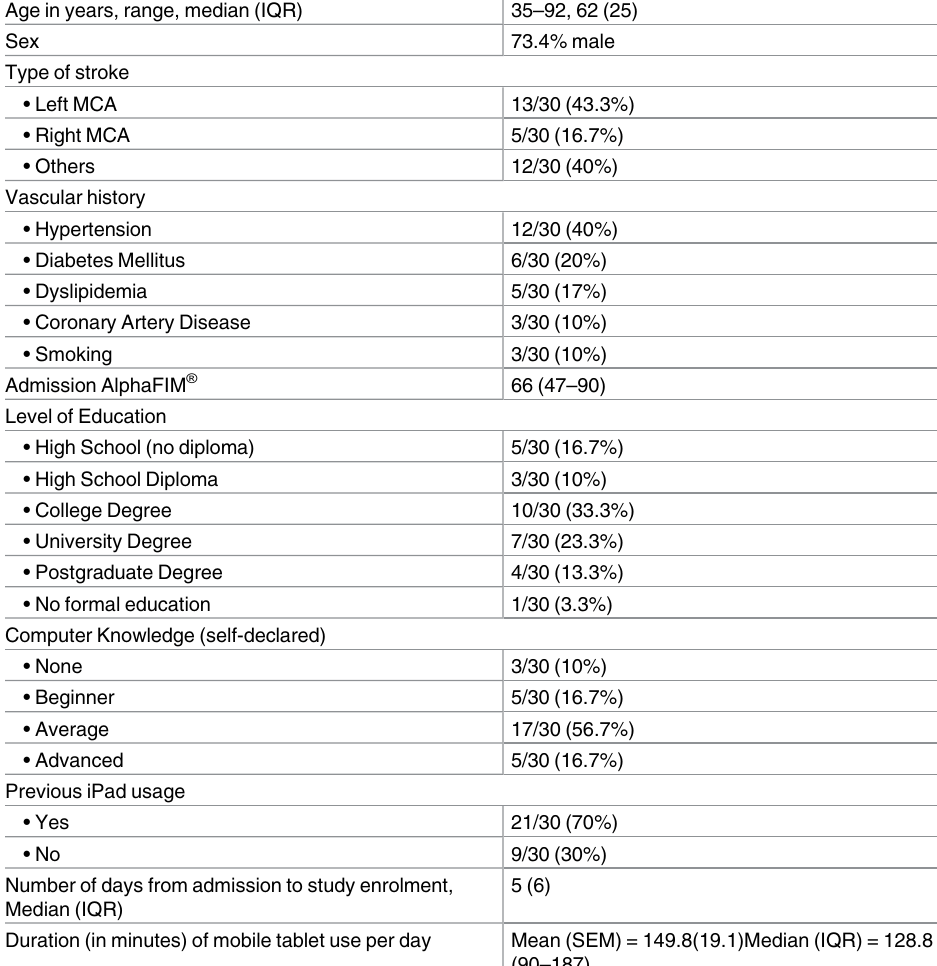
Table 2. Baseline demographics of enrolled